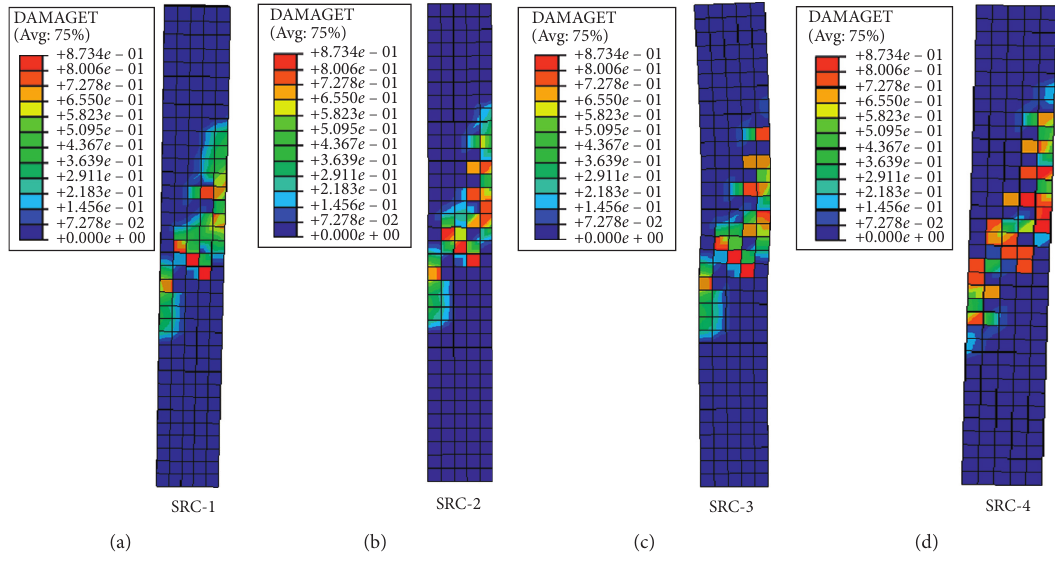
Figure 20: Initial cracking of